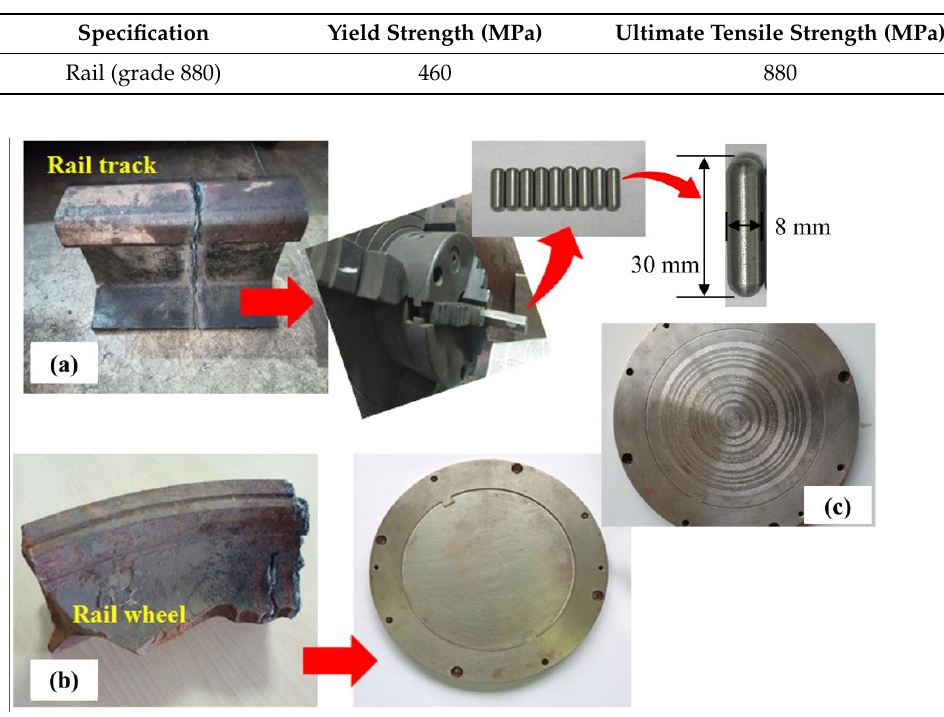
Table 3. Chemical components in rail [33].